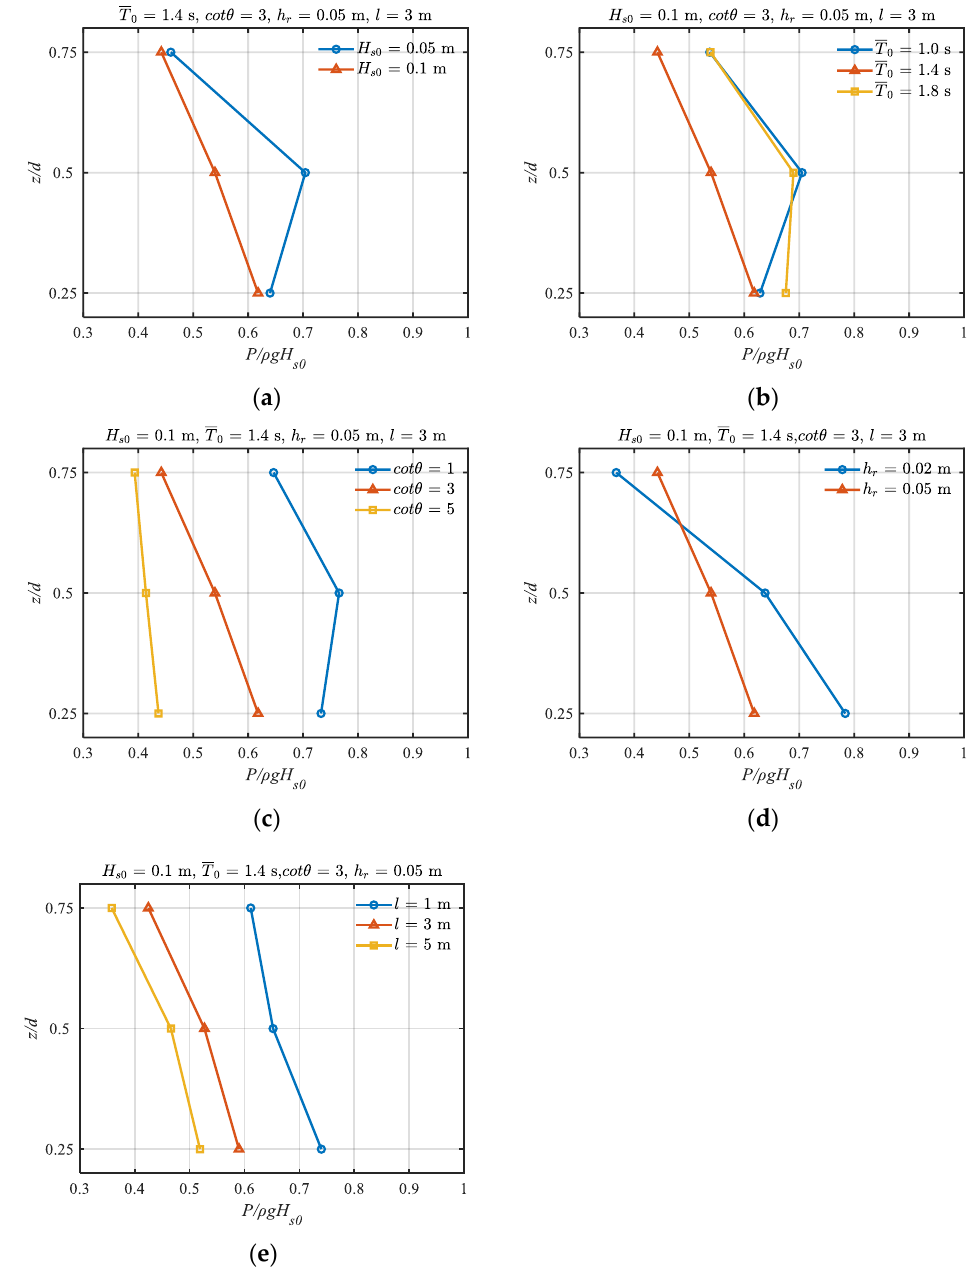
Figure 19. Irregular wave peak pressure distribution along the seaward surface of sloped seawall for different cases: ( a ) H s 0 ; ( b ) T 0 ; ( c ) cot θ ; ( d ) h r ; ( e ) l